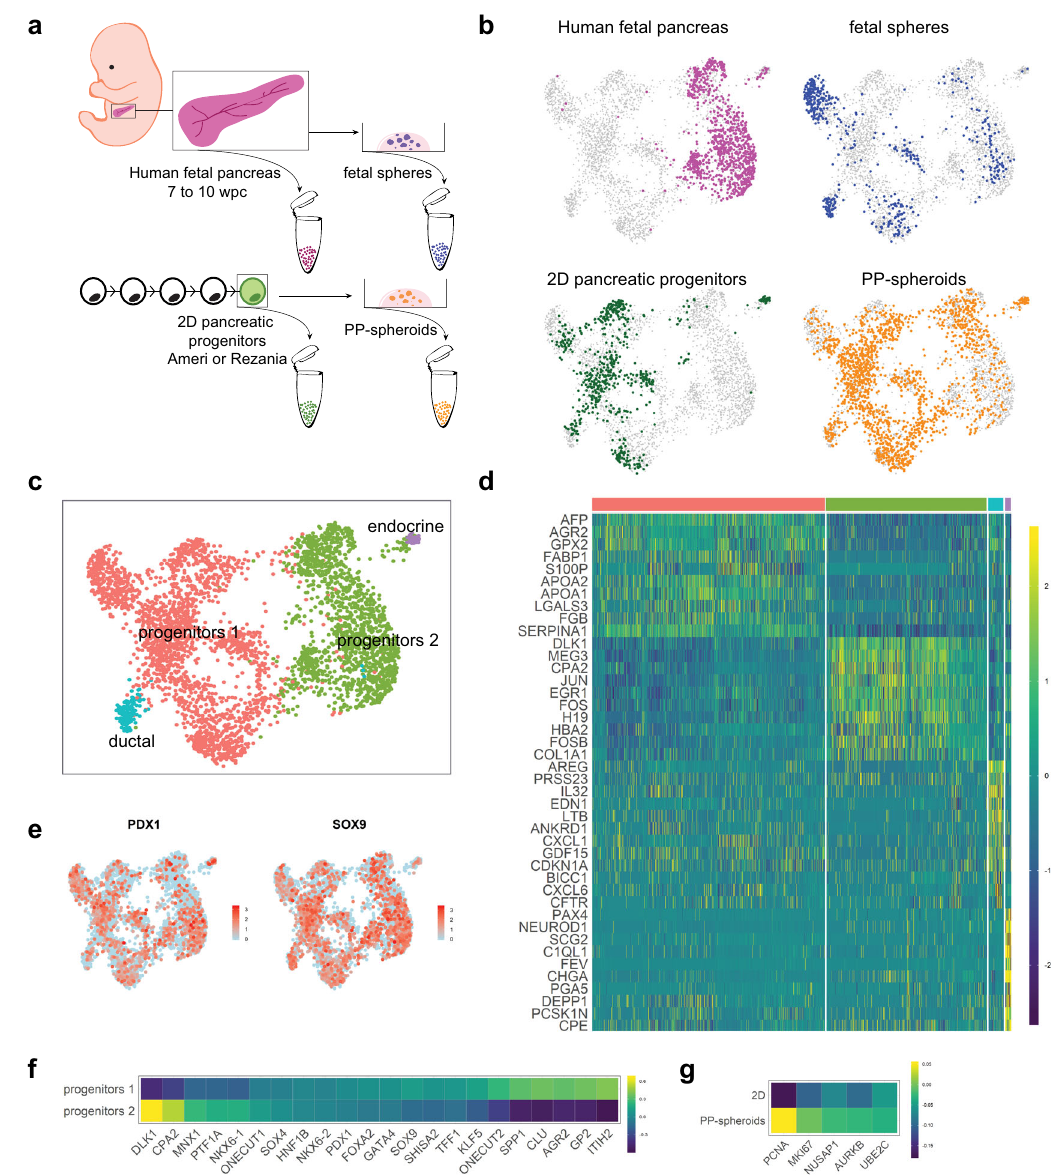
Fig. 3 Benchmarking of cells in vitro to human fetal pancreas. a In addition to fetal pancreas samples, we sequenced fetal spheres which are fetal pancreas cells cultured in expansion conditions; 2D pancreatic progenitors which are hPSCs differentiated with one of two protocols; and PP-spheroids which are hPSC differentiated in vitro and cultured in 3D in expansion conditions (HUES4, H1, SBAD3.4). b UMAP plots of the overall data after removing non-epithelial cells (mesenchymal, neuronal, and blood cells). In each plot the cells are highlighted according to their known origin. c Cells are colored according to their cluster identity, assigned by unsupervised clustering. d A heatmap of the top ten genes enriched in each cluster. e UMAP showing broad expression of the pancreatic progenitor genes PDX1 and SOX9 . f Global average counts in progenitors 1 and progenitors 2 for selected pancreatic genes highlighting differences between the two populations. g Global average counts in PP-spheroids and 2D progenitors for selected genes associated with cell proliferation. See also Supplementary Fig.